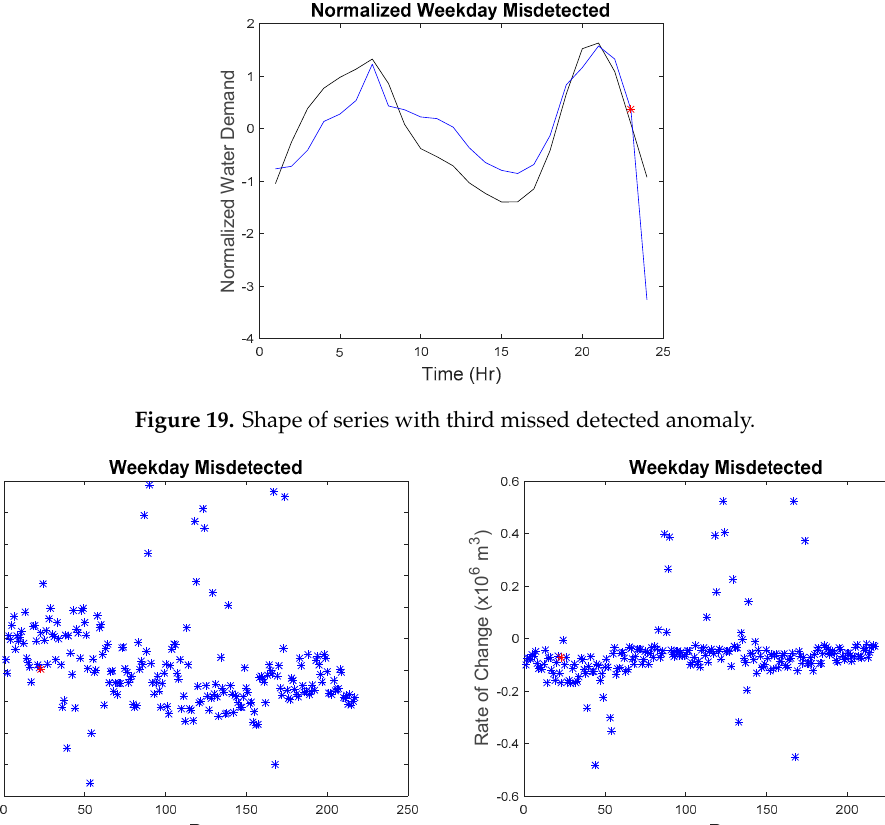
Figure 18. Comparison of second missed detected anomaly with other points.